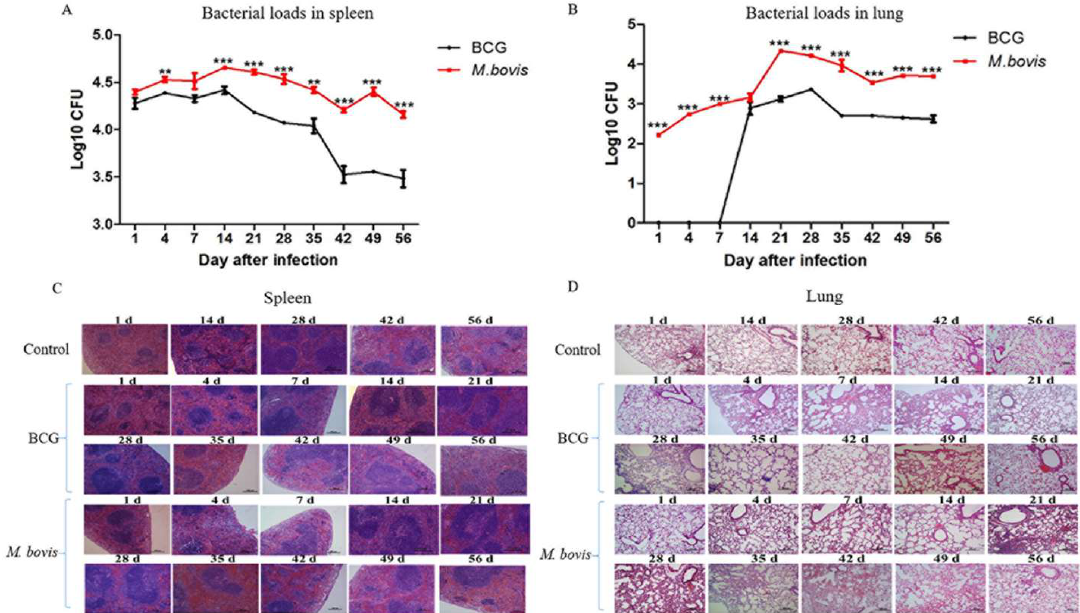
Figure 6. Bacterial loads and histopathological change in the spleens and lungs of mice infected with M. bovis and BCG. Mice were infected with M. bovis and BCG by tail vein injection with 2 × 10 5 CFU/mouse and sacrificed on 1, 4, 7, 14, 21, 28, 35, 49, and 56 days. ( A ) The bacterial load (CFU) in